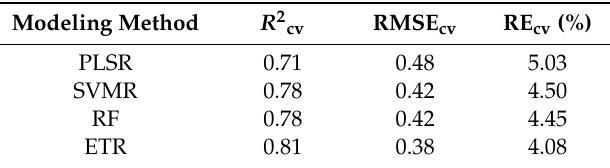
Table 3. Accuracy validation of the di ff erent